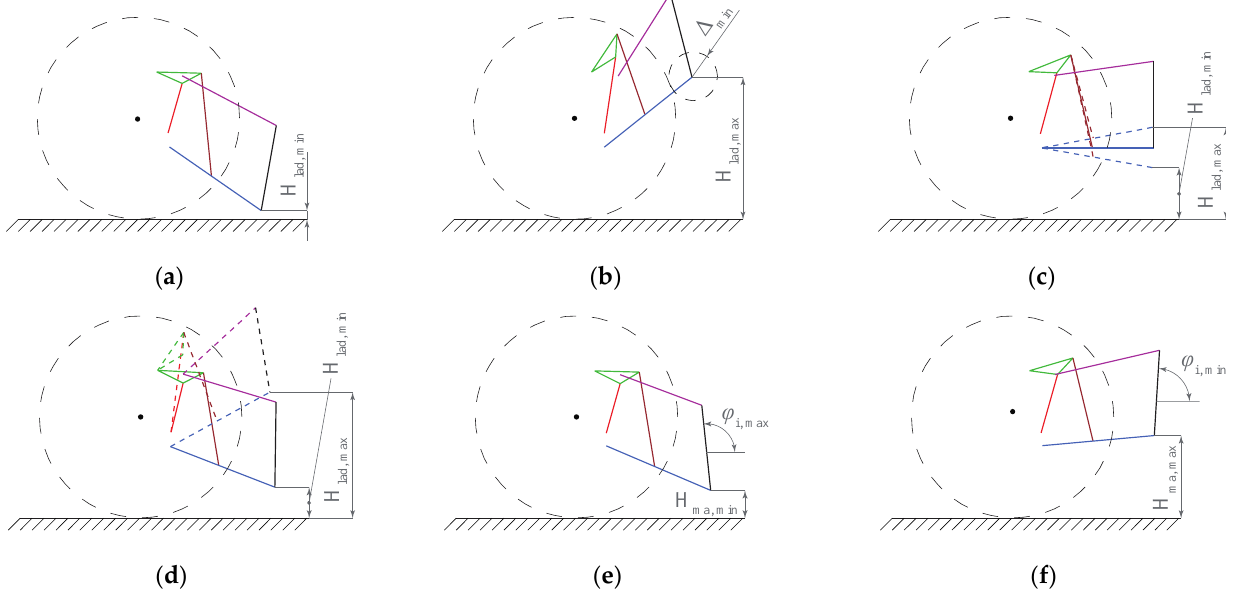
Figure A1. TPH configurations used to enforce constraints C22 – C36 (Table 1).